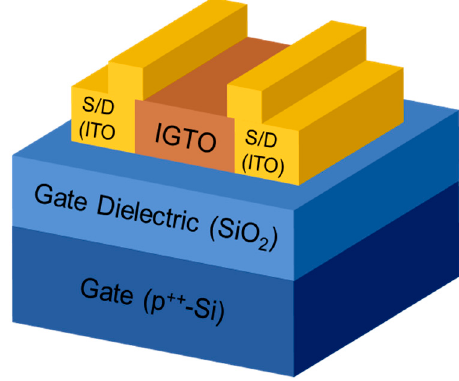
Figure 1. Cross-sectional schematic diagram of the fabricated indium-gallium-tin oxide (IGTO) thin-film transistors (TFTs).